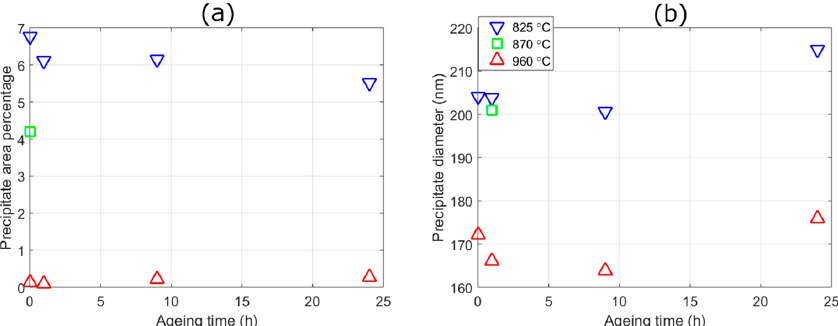
Figure 4. Precipitate area percentage ( a ) and precipitate equivalent circular diameter ( b ) from back-scattered SEM images and image-J analysis. The three different austenitisation temperatures are shown at a range of ageing times (870 °C has only been measured at 0 h). An indication of the errors in the results are shown in Table 2.